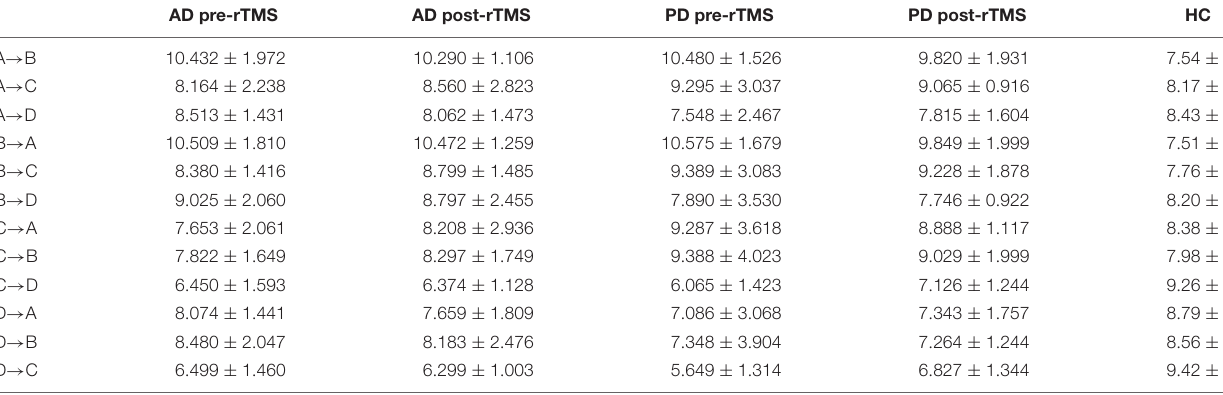
TABLE 5 | Expected microstate transitions (%) of healthy control (HC), AD and PD groups at pre and post-TMS. AD pre-rTMS AD post-rTMS PD pre-rTMS PD post-rTMS